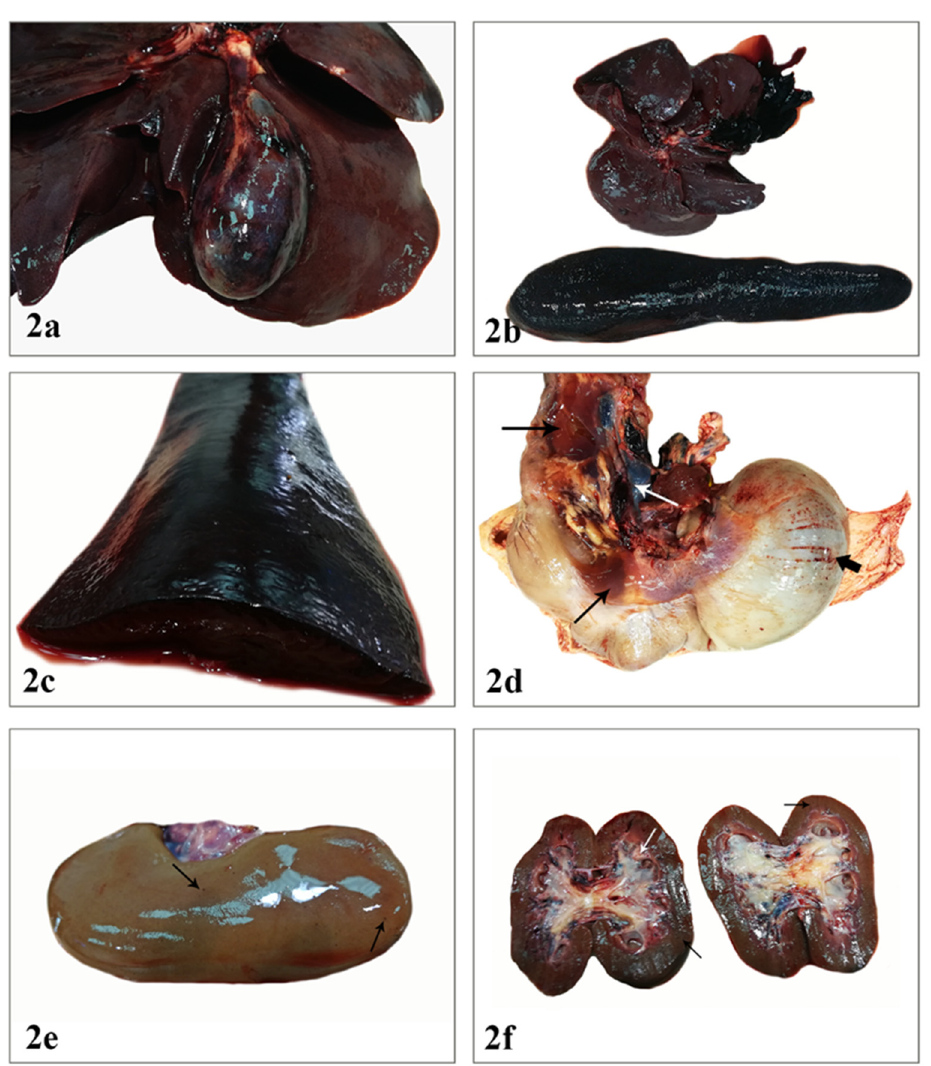
Figure 2. ( a ). The gallbladder is distended with multiple detectable subserosal hemorrhages. ( b ). Severe and homogenous enlargement of the spleen. The gallbladder contents appear dark red and viscous mixed with blood. ( c ). The spleen on the cut surface is solid and hyperemic with a dark cherry color. ( d ). Gastric lymph nodes are enlarged and dark red in color (white arrow). Note the linear subserosal hemorrhages (thick black arrow). Intense edema along the lesser curvature (thin black arrows). ( e ). Few scattered petechiae are observed on the surface of the renal cortex (arrows). ( f ). Sparse petechiae are present in the renal cortex, medulla, and the calyces of both kidneys (ar- rows).